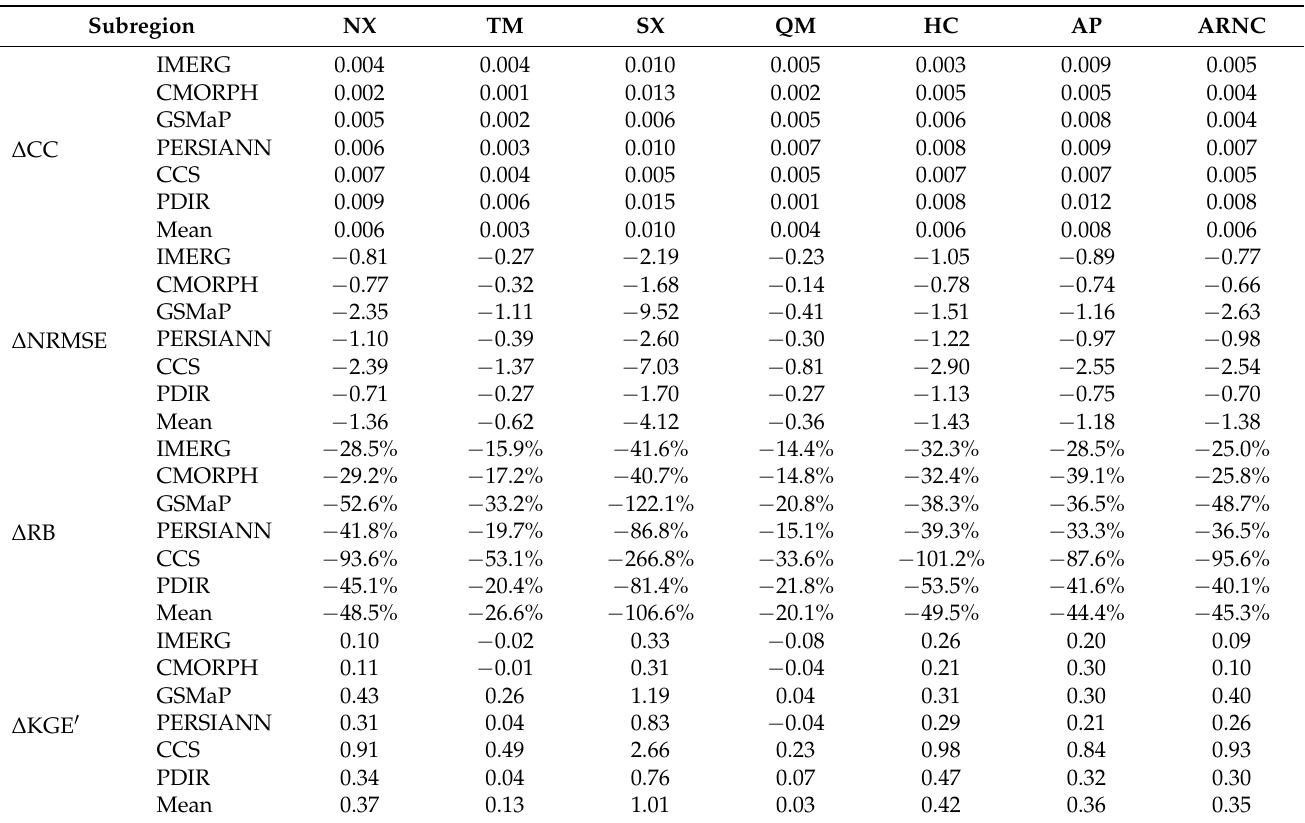
Table 3. The changes of continuous metrics of SPPs in each